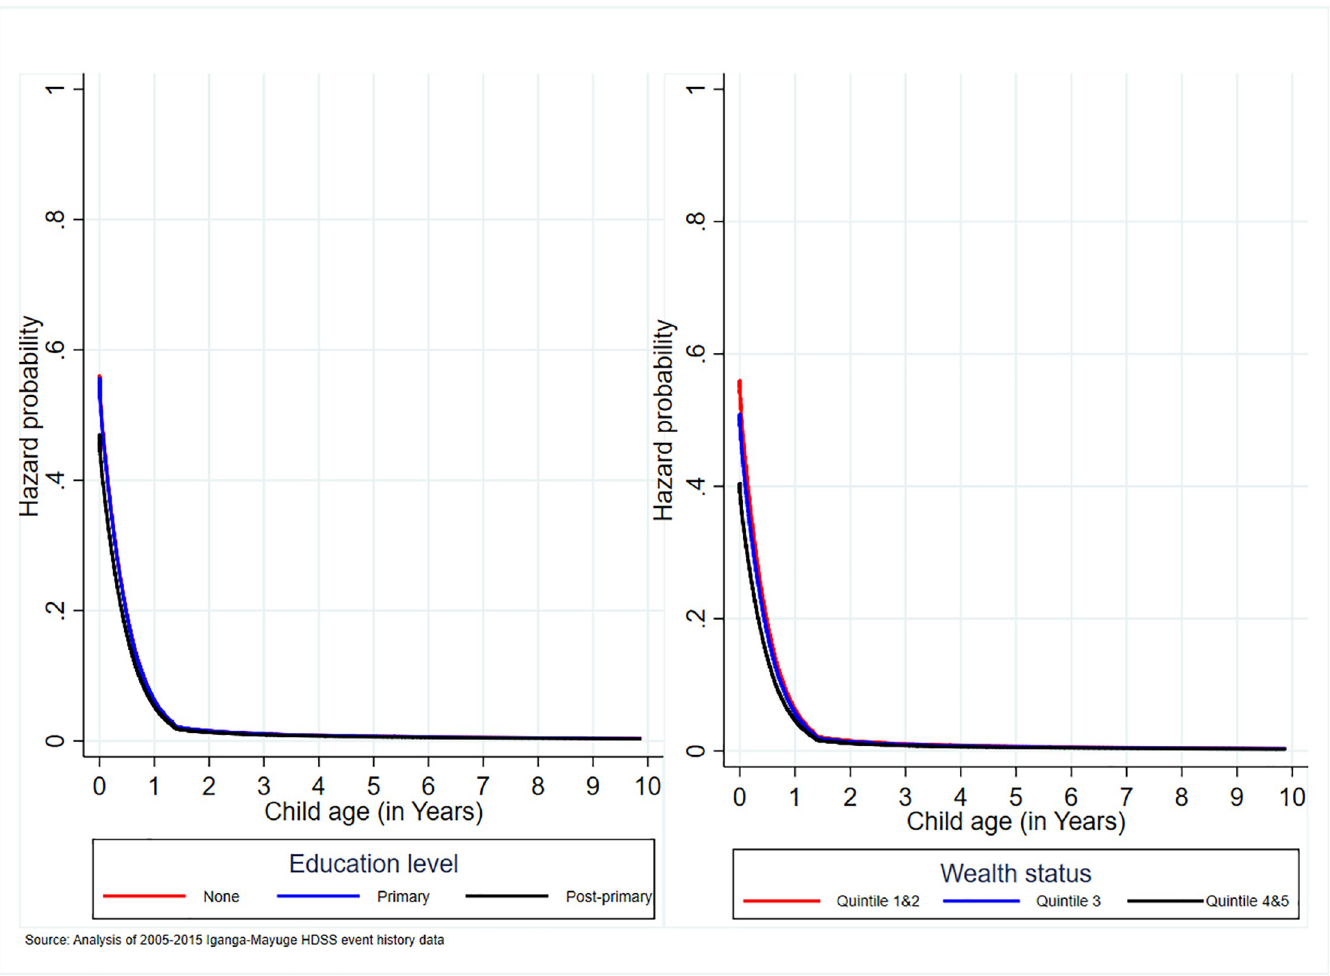
Fig 5. Association of maternal education and wealth status with under-10 mortality.